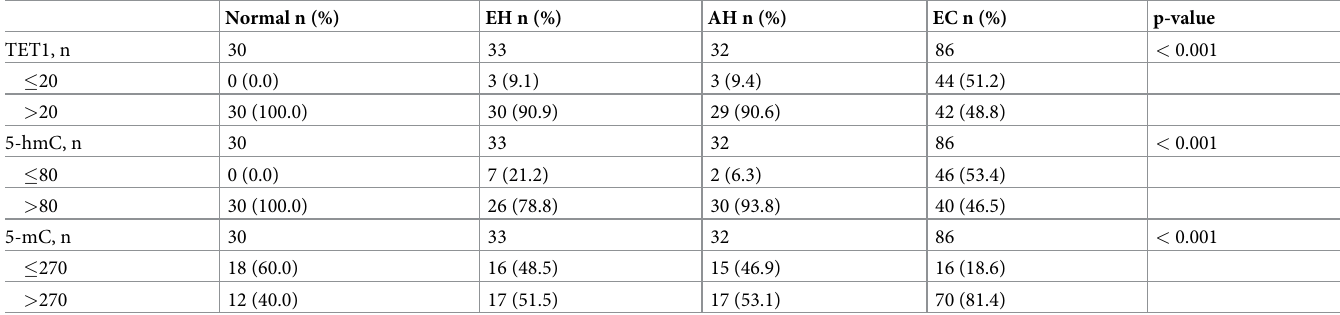
Table 1. Chi-squared test for TET1, 5-hmC, and 5-mC expression scores based on the area of staining and the intensity of color reaction.